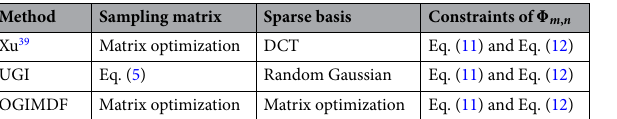
Table 1. The characteristics of three schemes in terms of sampling matrix and its constraints and sparse basis.